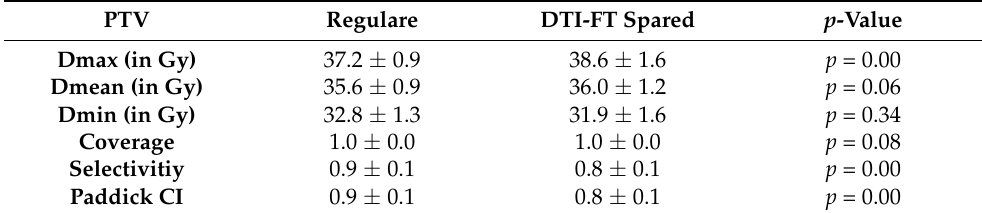
Table 3. Dosimetric values of PTV in regular treatment plans (regular) and with sparing (spare) DTI- FT based CST. In comparison, Dmean of the PTV is not negatively affected. Coverage of target volume is equal after plan optimization. Changes of prescription isodose volume (PIV) were observed which decreased Selectivity and Paddick CI after recalculation, however were still appropriate. Gradient indices changes are minor, even though significant.